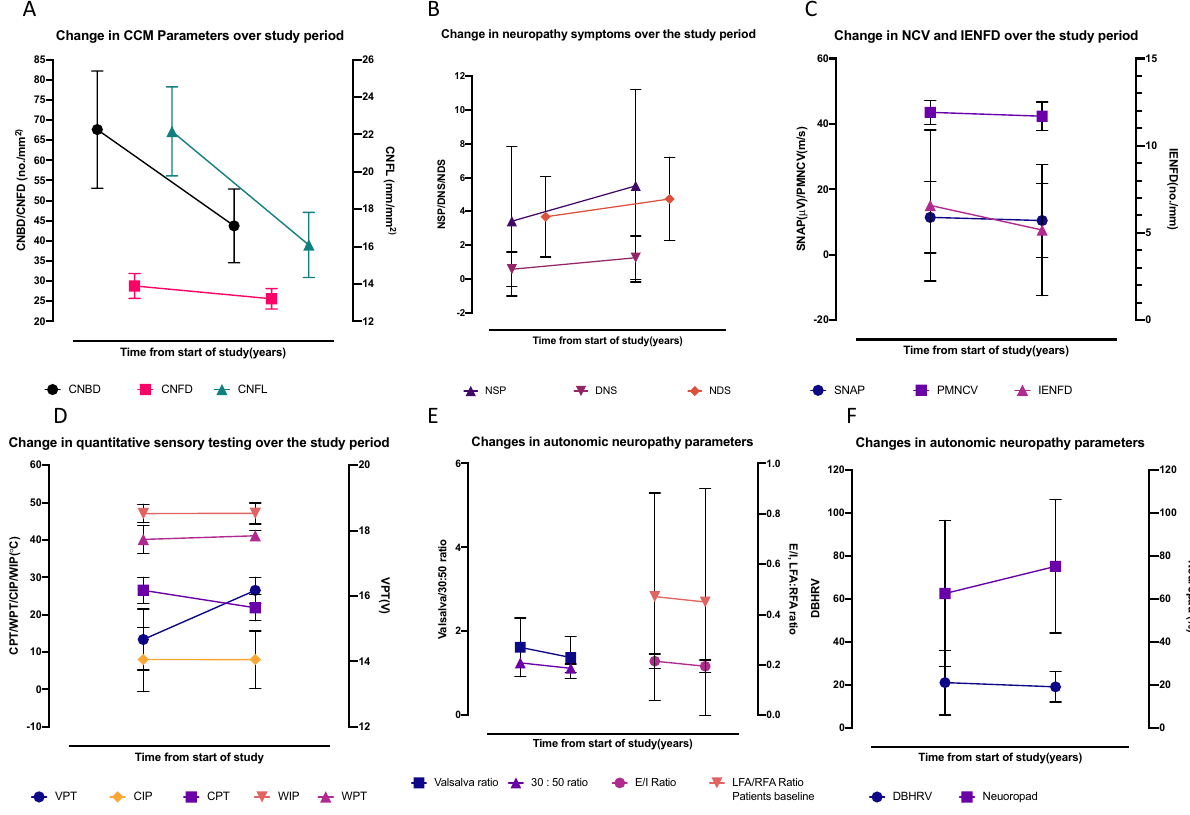
Figure 3. Percentage change from baseline values in CCM parameters ( A ), neuropathy symptoms ( B ), NCV and IENFD ( C ), quantitative sensory testing ( D ) and autonomic neuropathy ( E , F ).